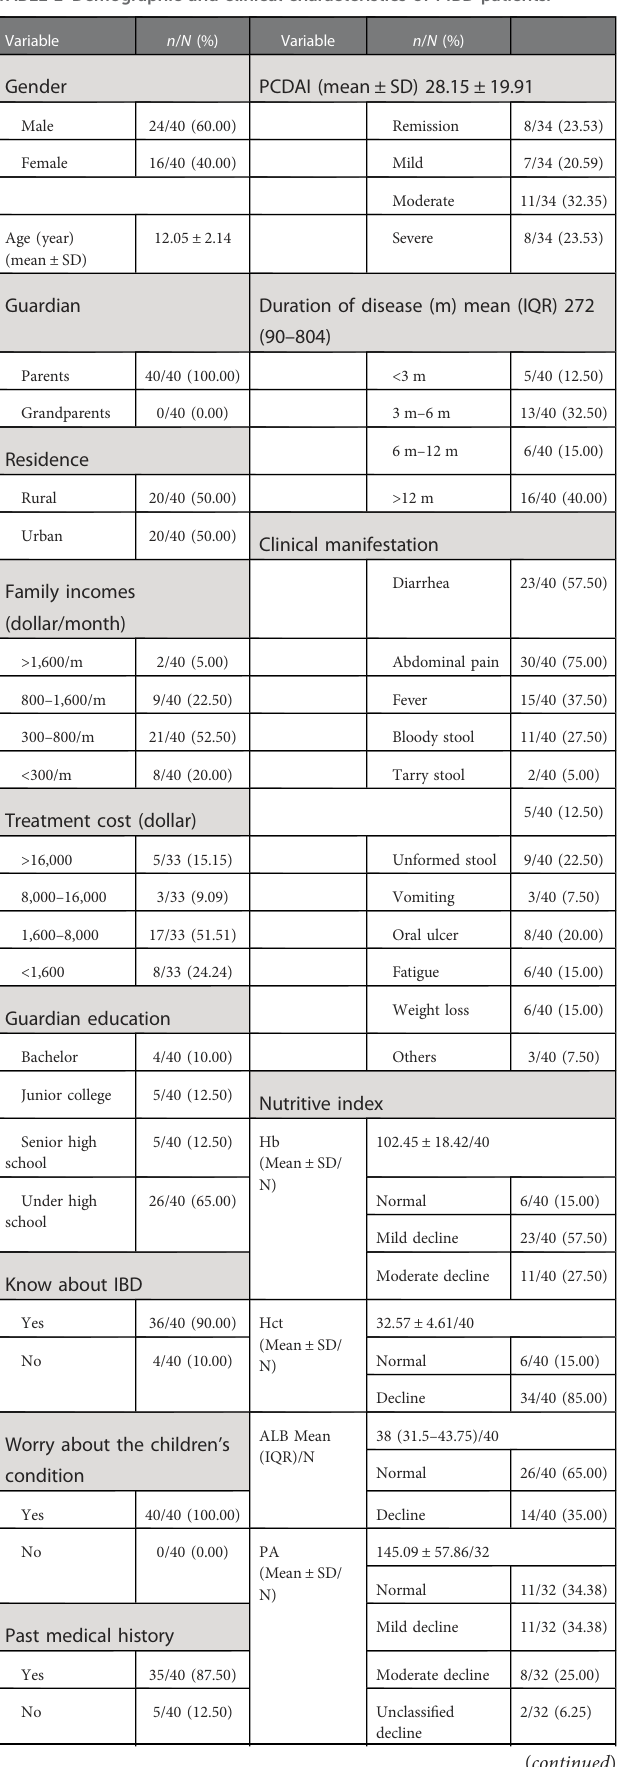
TABLE 1 Demographic and clinical characteristics of PIBD patients.